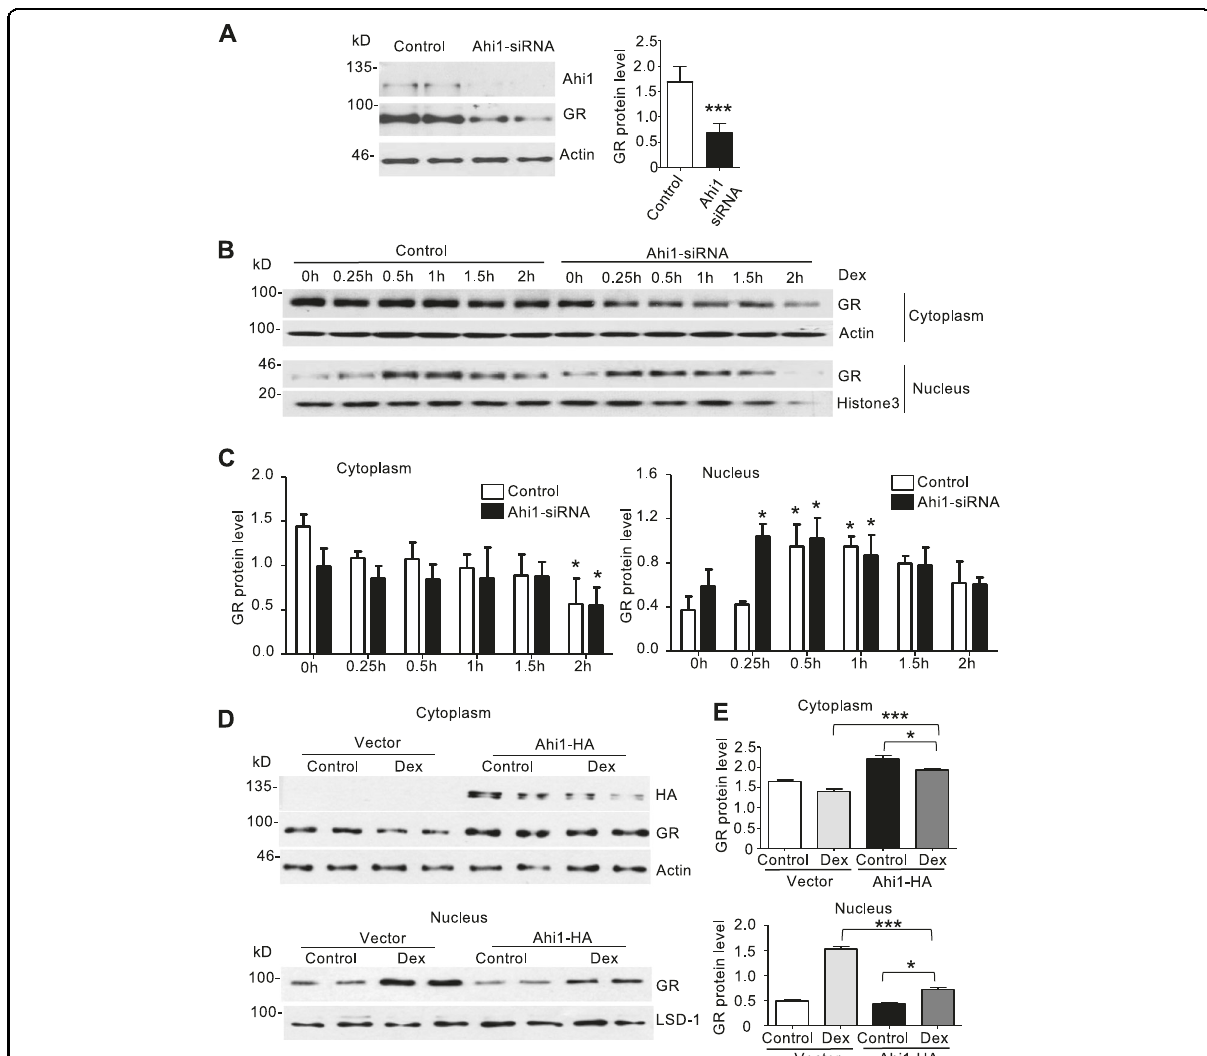
Fig. 4 Ahi1 inhibits GR nuclear translocation and stabilizes GR in the cytoplasm. A Ahi1 knockdown was performed in PC12 cells by using Ahi1 siRNA. Ahi1 and GR levels were detected by western blotting at 48 h after siRNA transfection. ( t (6) = 5.996, *** P = 0.001). N = 4 cell samples. B After Ahi1-siRNA transfection for 48 h, PC12 cells were treated with Dex (20 μ M) for different time (0 – 2 h). Nuclear and cytoplasmic GR levels were examined by Western blotting. Histone-3 and actin were served as nuclear and cytoplasmic protein controls, respectively. C The ratios of GR protein to actin or histone-3. * P < 0.05 versus control group ( n = 3 cell samples). D PC12 cells were transfected with PRK-Ahi1-HA plasmids or PRK vector for 48 h and then treated with Dex (20 μ M) for 0.5 h. Cytoplasmic and nucleic fractions were isolated. GR was determined by western blotting in both fractions. LSD-1 and β -actin were used as loading controls of nuclear and cytoplasmic proteins. E The ratios (mean± SEM) of GR to LSD-1 or actin ( n = 4 cell samples). * P < 0.05, *** P <